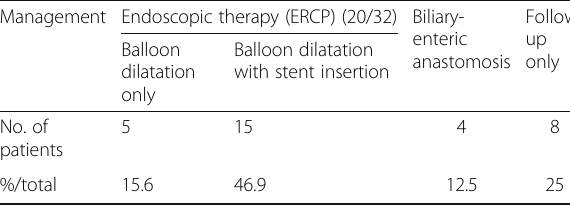
Table 4 Types of management of post-transplant biliary